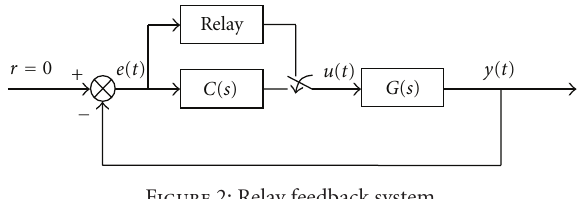
Figure 2: Relay feedback system.